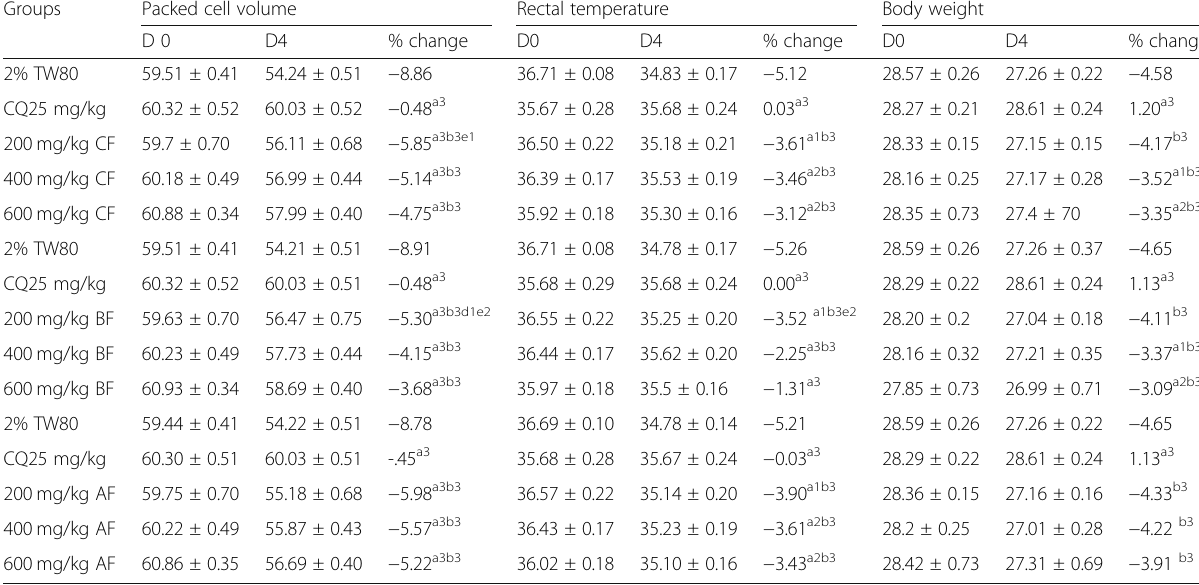
Table 8 Packed cell volume, rectal temperature and body weight of infected mice treated with solvent fractions of the leaves of Olea europaea in the 4-day suppressive test Groups